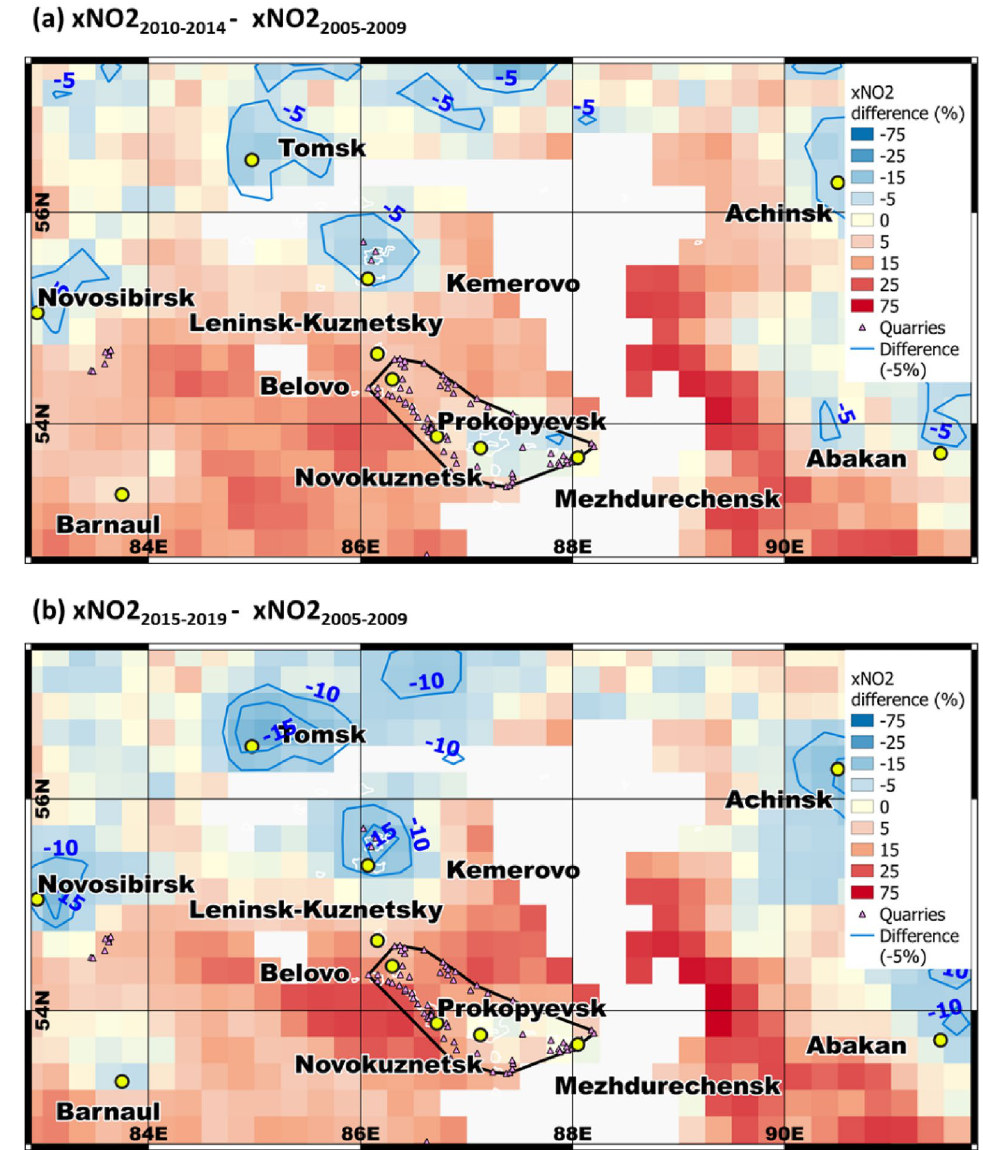
Figure 6. Change in average NO 2 from 2005–2009 to ( a ) 2010–2014 and ( b ) 2015–2019. Blue shading represents a decrease in NO 2 and red indicates an increase. Yellow circles mark the largest cities in the region, and small pink triangles indicate coal mines. The pixel size is 0.25° × 0.25°. This analysis was conducted for retrieving NO 2 over areas with elevated NO 2 concentrations, including cities and the cluster of coal mines in Kuzbass, whereas the hinterlands were less important for this analysis given the lower tropospheric NO 2 over these areas (Fig. 3). To this end, the NO 2 data from areas with relatively low NO 2 were masked out (white areas). Areas with low NO 2 were defined as follows: the NO 2 concentration for a 0.25 × 0.25 grid cell is less than the mean NO 2 concentration over Kuzbass for the period